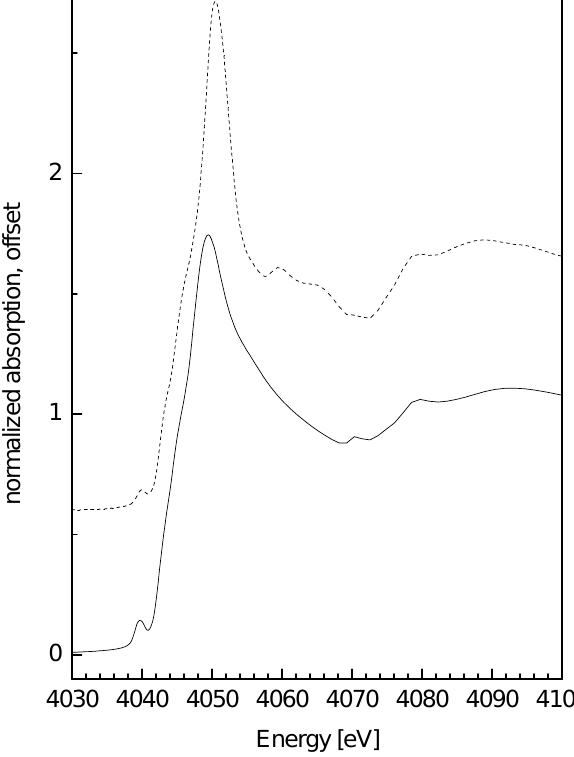
Fig. 4. Ca K-edge X-ray near edge structure (XANES) spectrum of precipitates from arctic sea ice stored in pure ethanol (solid line) compared to a spectrum of synthetic ikaite (dashed line). The spec- trum of ikaite stored in pure ethanol matches with the ones of amor- phous calcium carbonate (ACC) in Michel et al.